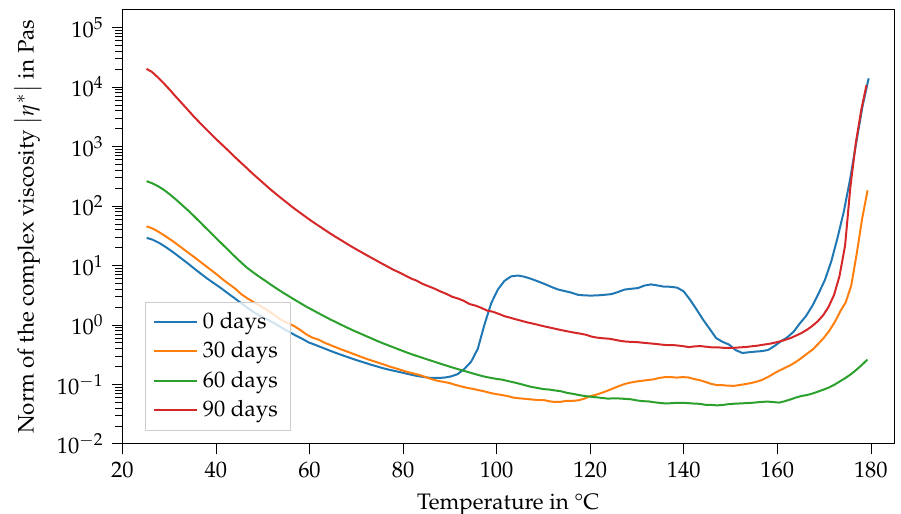
Figure 6. Norm of the complex viscosity of Argopox-1 between 25°C and 180°C after storage periods of 0d, 30d, 60d and 90d at T = 22°C.